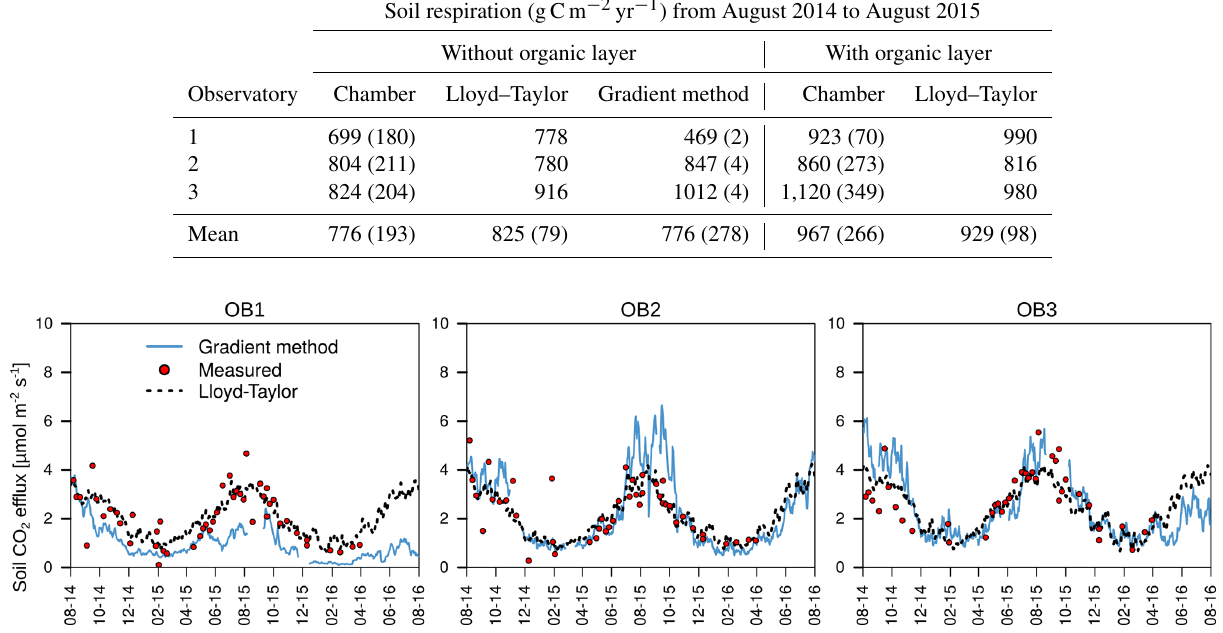
Figure 4. Mean daily soil respiration determined with the gradient method, measured with chambers and modelled with a Lloyd–Taylor function for the observatories